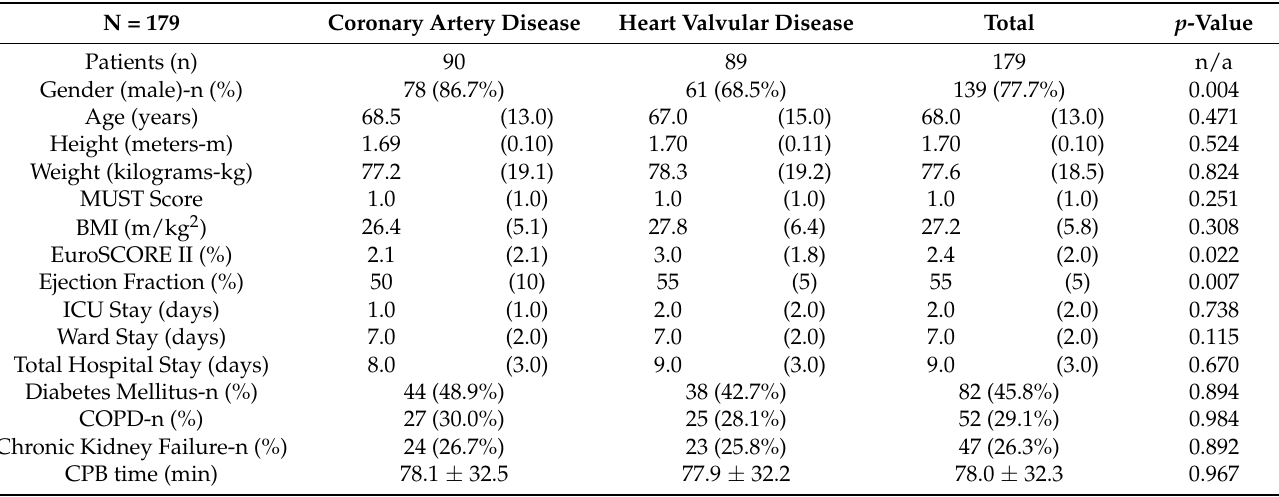
Table 1. Demographic and clinical characteristics of the